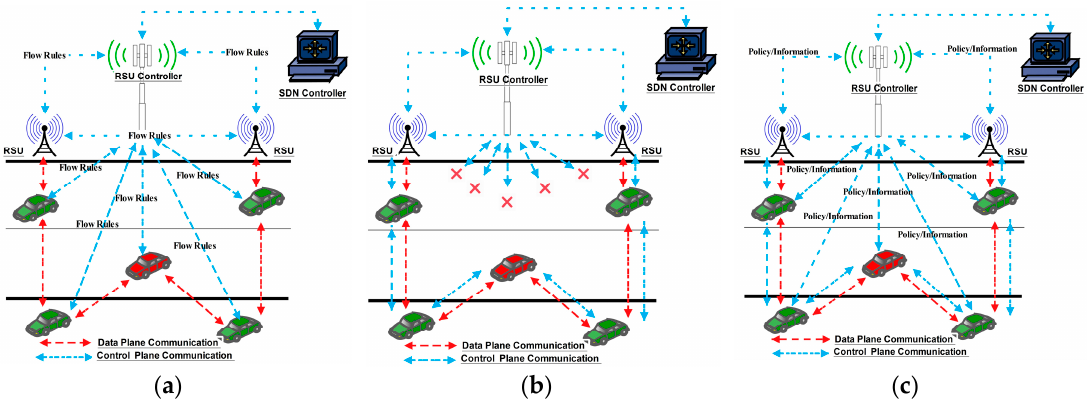
Figure 4. ( a ) Centralized controller model, ( b ) distributed controller model, ( c ) hybrid controller